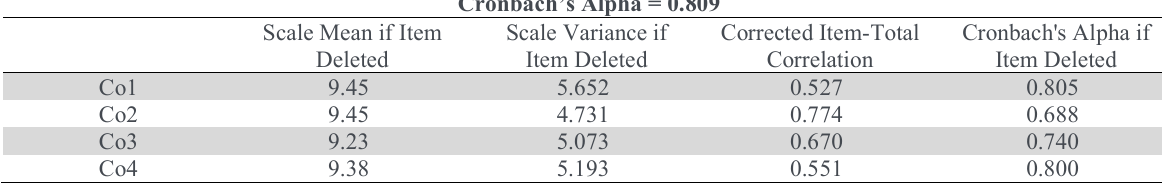
Cronbach’s Alpha test results of knowledge collection